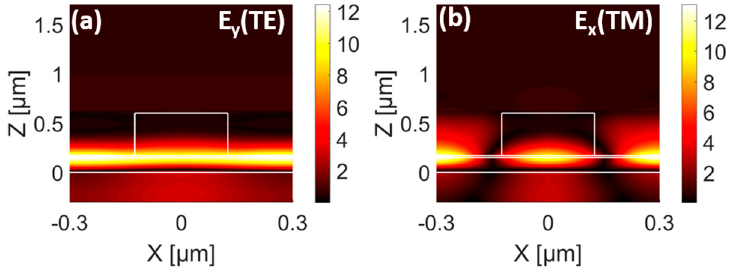
Figure 4. Field profiles ( a ) amplitude of Ey component and ( b ) amplitude of Ex component at 0.9 µm without the graphene layer. The white lines show the device structure.